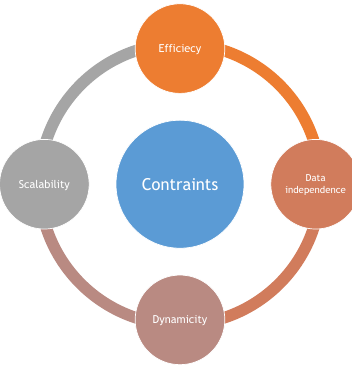
Figure 5. Big Data indexing